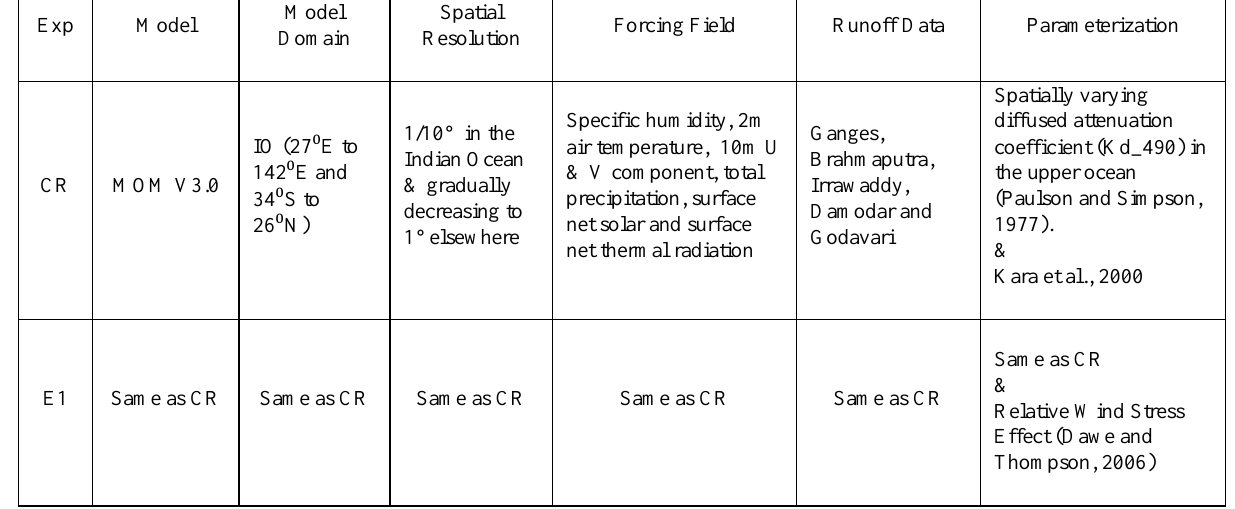
Table 2: Configurations name and setting used for sensitivity tests and experiments.